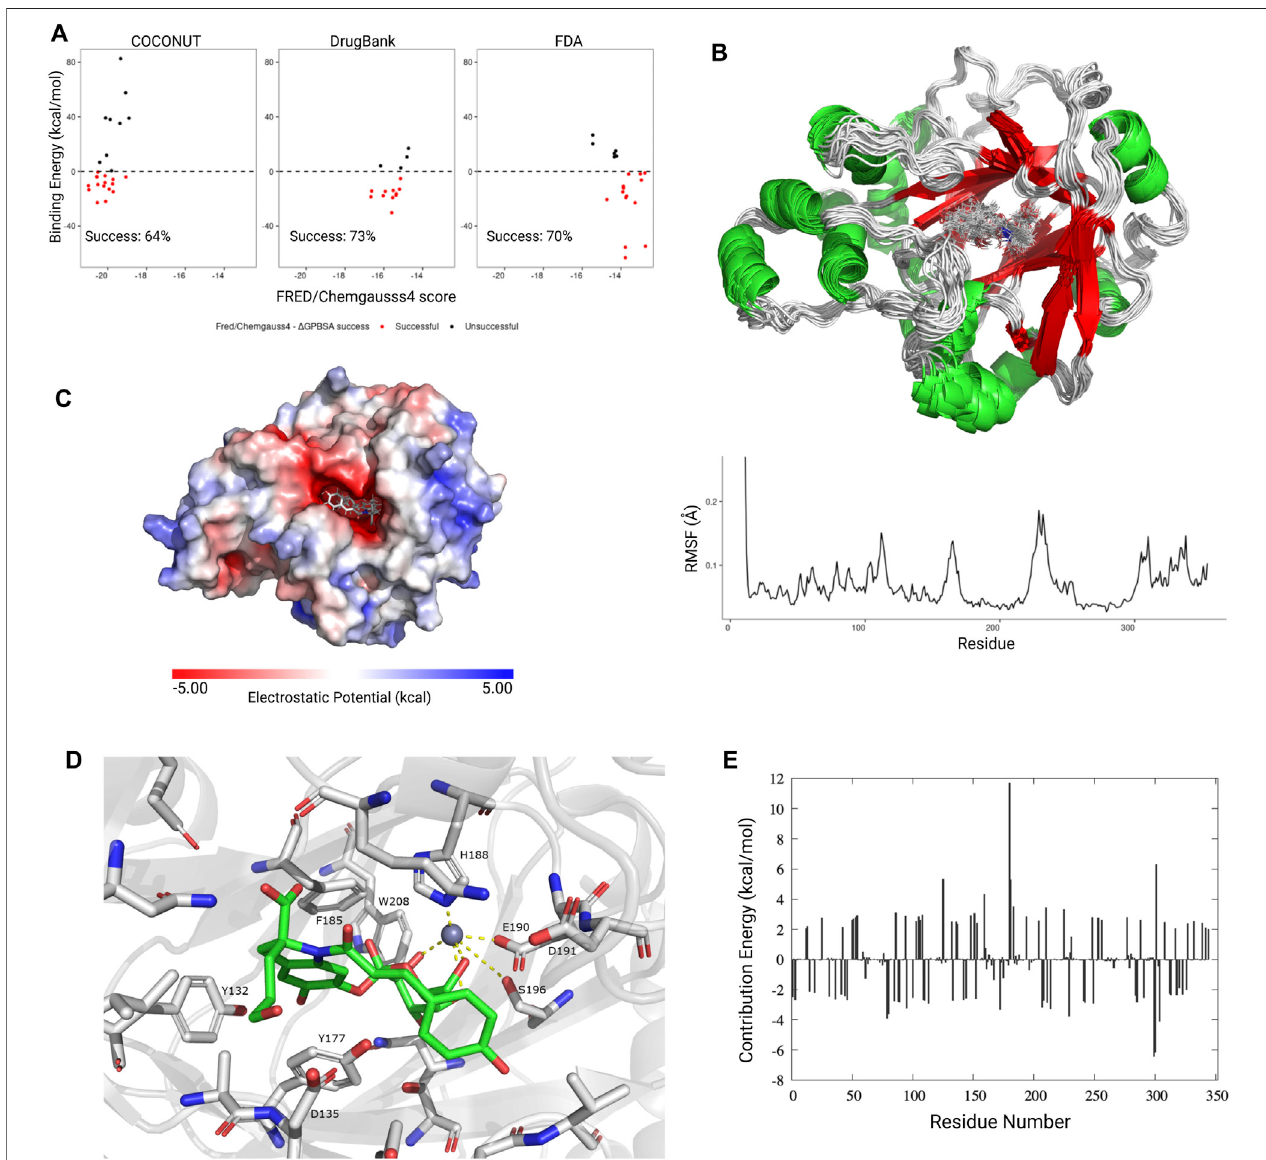
FIGURE 5 | Molecular dynamics simulations and absolute binding energy calculation. (A) FRED/Chemgauss4 vs Δ G PBSA correlation for the best scoring ligands from each database. Ligands that showed a favorable binding energy ( < 0 kcal/mol) and negative FRED/Chemgauss4 score were considered as successful (red dots). The success percentage represents the proportion of successful molecules for each database. (B) Upper panel : Graphical representation (20 frames) of the molecular dynamics simulation for KDM4A (PDB ID: 5F32) in complex with the CNP0371131 ligand from COCONUT. Lower panel: RMSF value for each residue. (C) Electrostatic potential for the KDM4A-CNP0371131 complex. (D) Graphical representation of the CNP0371131 molecule (green) bound to KDM4A ’ s catalytic site. The residue numbers correspond to PDB structure 5F32. (E) Average per residue MM-PBSA binding free energy contribution for the KDM4A-CNP0371131 complex.